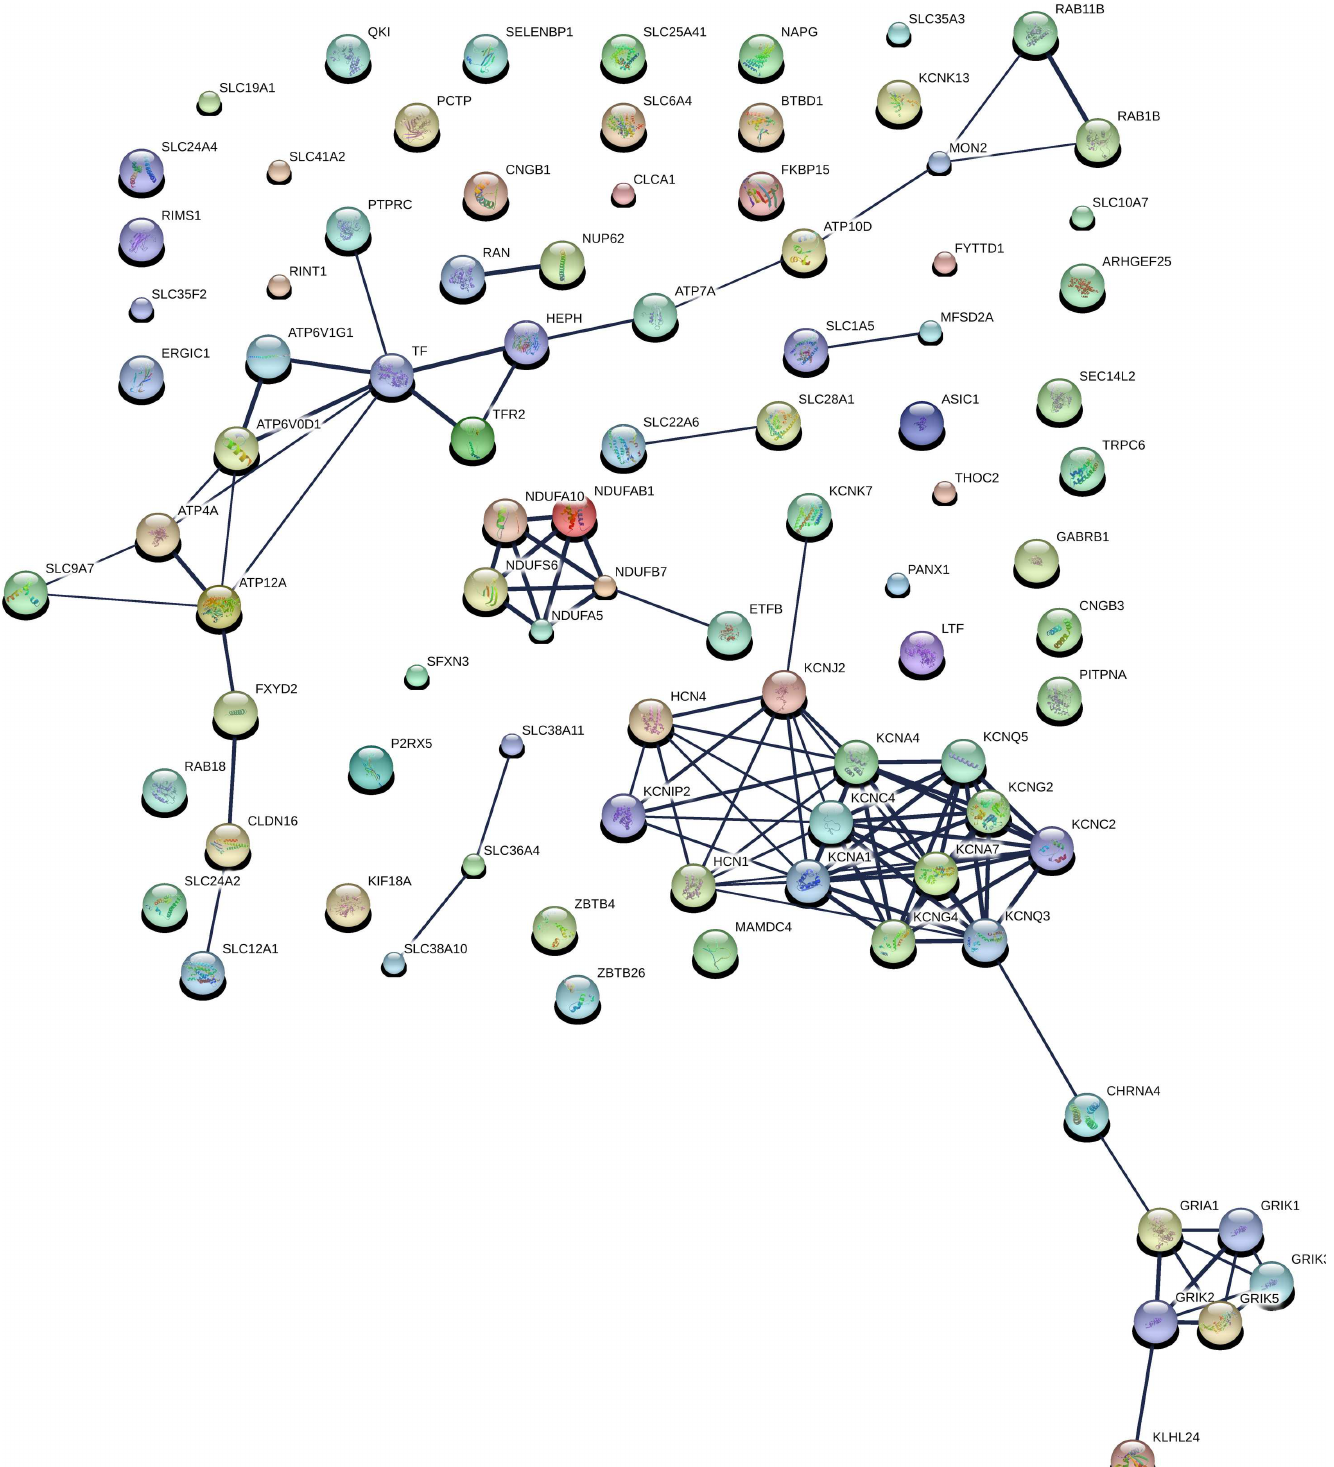
Fig 1. The most prominent Sting-derived subnetwork that promotes the invasion of epithelial cells by S . typhimurium. The subnetworkis involved in potassium transport.